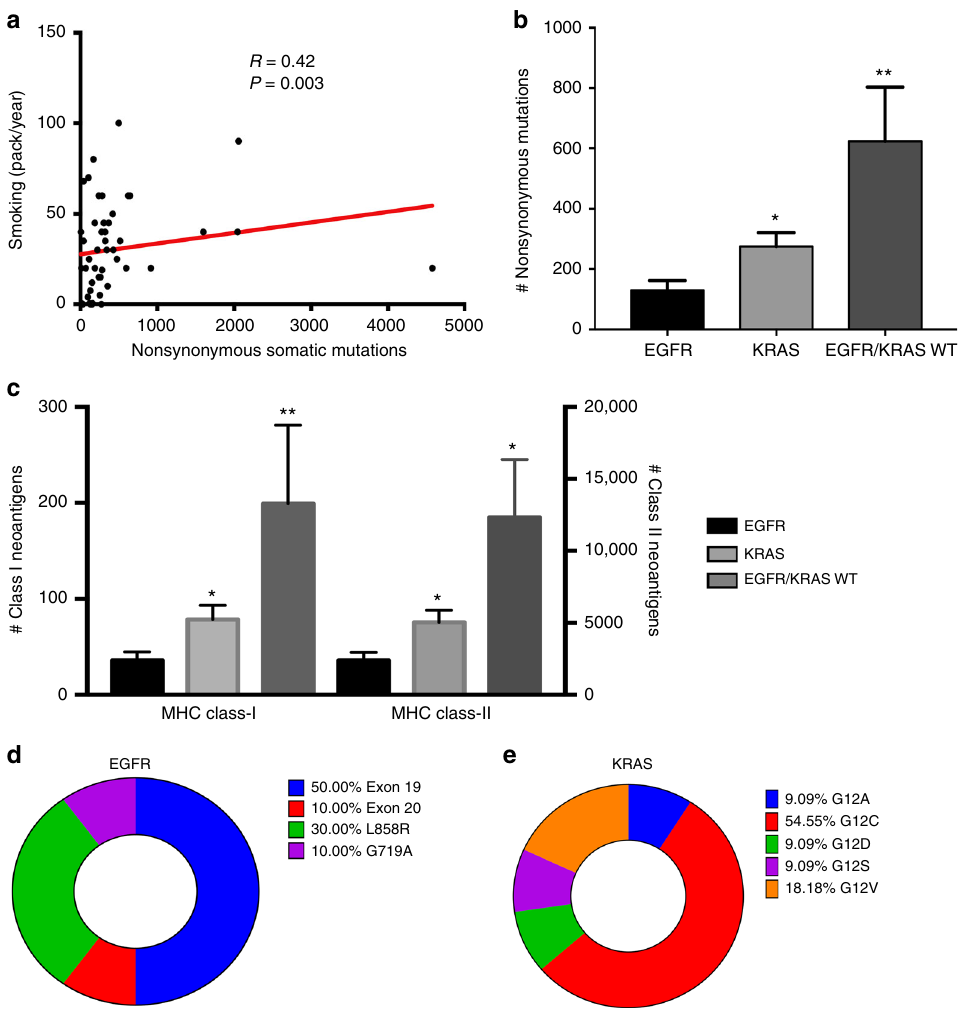
Fig. 3 Association between the mutations, predicted MHC class-I neoantigens, major oncogenic drivers and tobacco consumption. a Association between the mutational load and the level of cigarette smoking in lung cancer patients treated with immune checkpoint blockers. R = Spearman ’ s rho rank correlation coef fi cient. b , c Charts showing the number of nonsynonymous mutations ( b ) or candidate HLA class-I and class-II neoantigens. c In lung tumors treated with immune checkpoint blockers harboring mutations in EGFR ( N = 8), KRAS ( N = 11) or lacking mutations in both oncogenes ( N = 30). Error bars indicate S.E.M. * P < 0.05; ** P < 0.01, Mann – Whitney test. d , e Frequency of the speci fi c variants identi fi ed in NSCLCs with EGFR ( d ) and